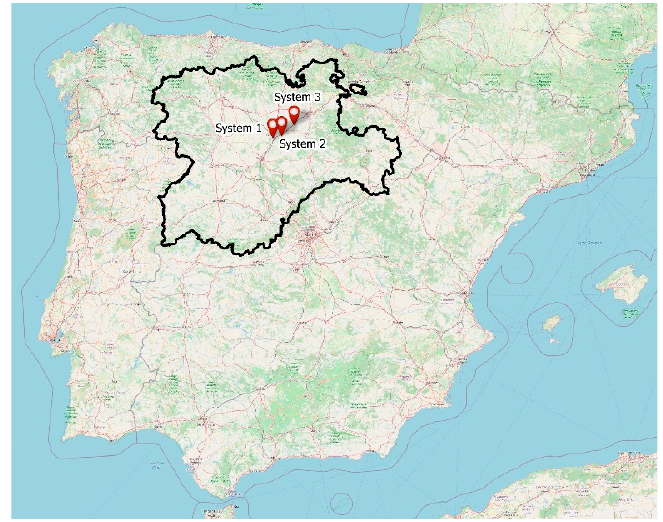
Figure 1. Geographical location of the three facilities.